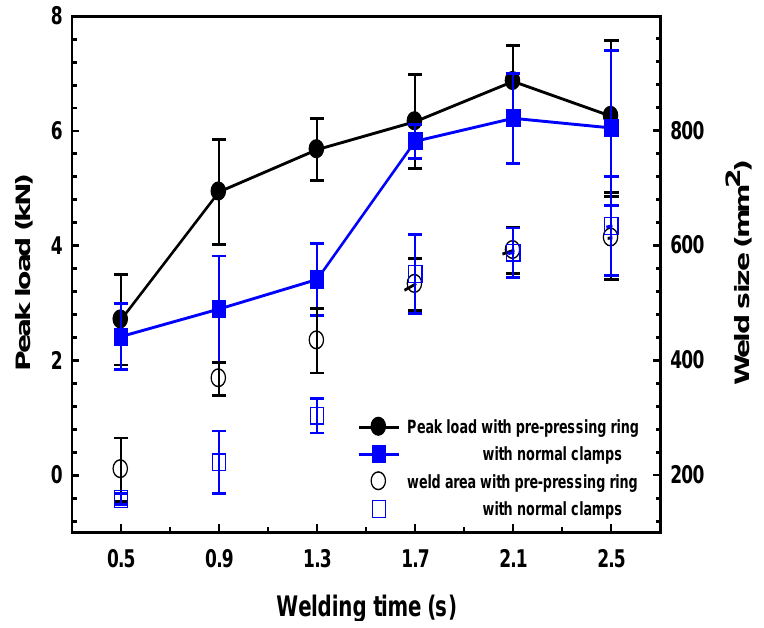
Figure 5. Correlation among the weld time, joint strength, and weld size of the UW joints welded with two kinds of clamps.